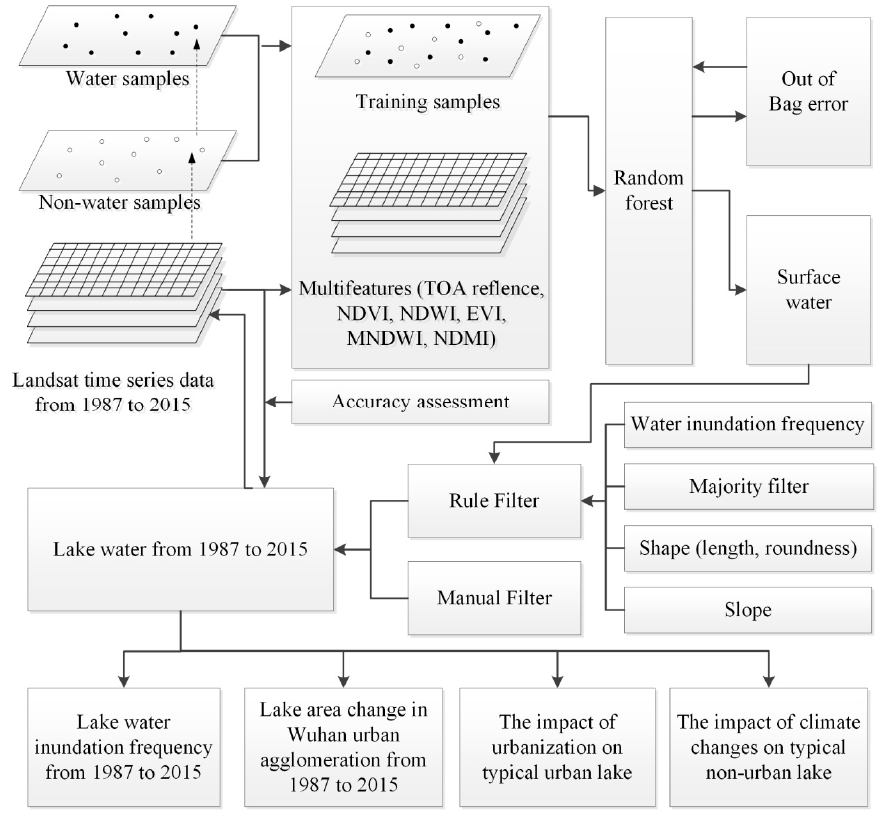
Figure 3. Flowchart of the study.